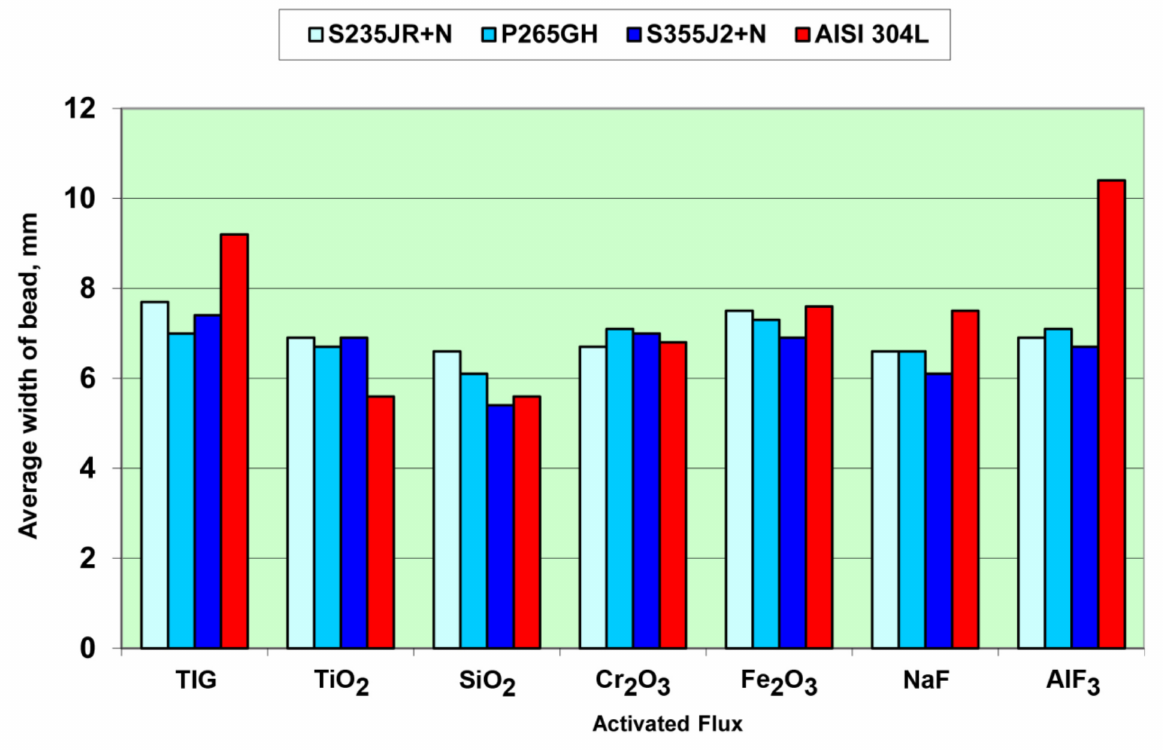
Figure 7. Correlation between the average width of the weld and the types of activated